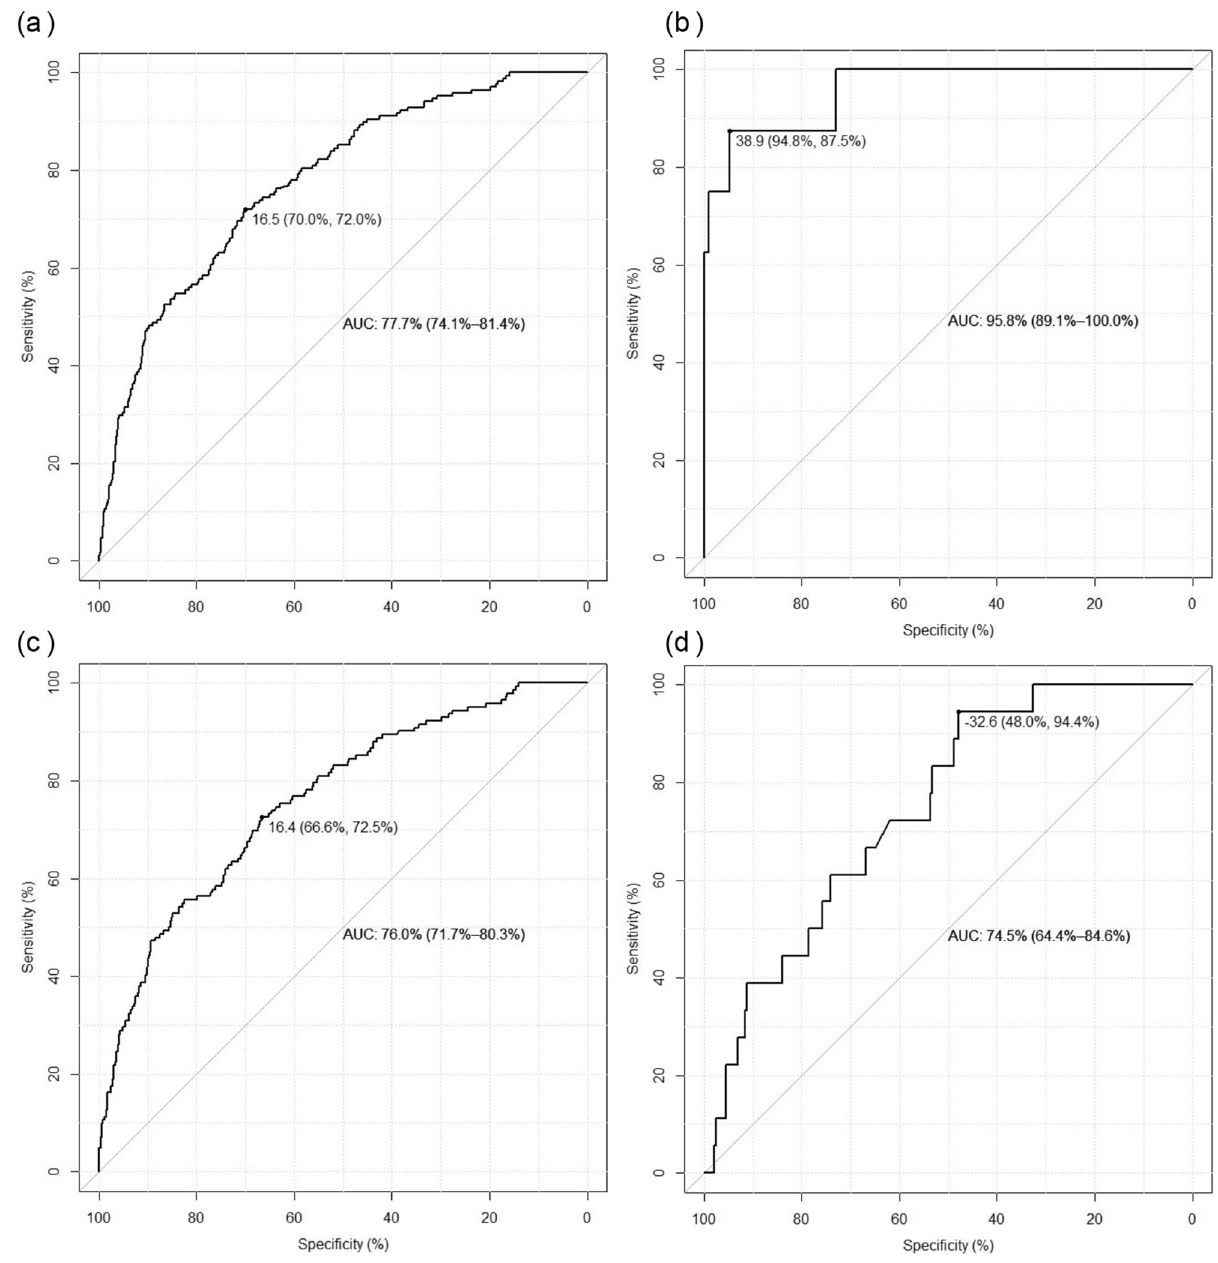
Figure 3. Receiver operating characteristic (ROC) curve analysis with the area under the curve (AUC) method in ( a ) whole cohort; ( b ) patients treated with chemotherapy plus anti-epidermal growth factor receptor (EGFR) monoclonal antibody (mAb); ( c ) patients treated with chemotherapy alone; ( d ) patients treated with chemotherapy plus anti-vascular endothelial growth factor (VEGF)